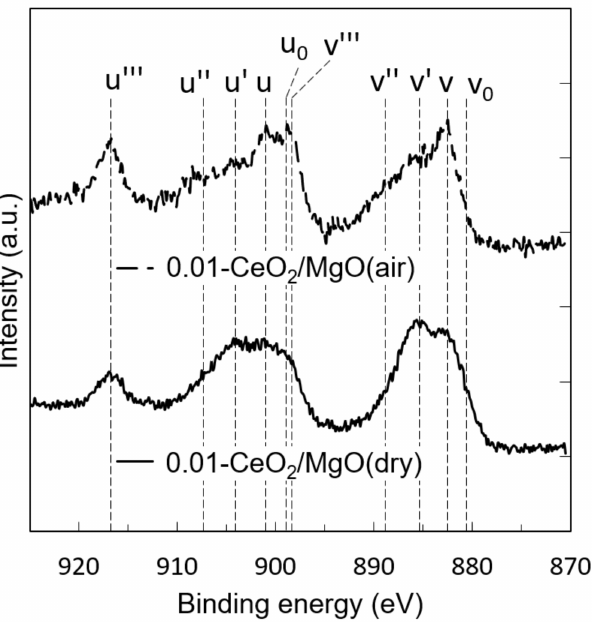
Figure 6. XPS spectra of 0.01-CeO 2 /MgO(air) and 0.01-CeO 2 /MgO(dry). The peak positions of v 0 , v, v’, v”, v”’, u 0 , u, u’, u”, and u”’ are 880.60, 882.60, 885.45, 888.85, 898.40, 898.90, 901.05, 904.05, 907.45, and 916.70 eV, respectively. The binding energies of all the peaks are identical to the values of the reference